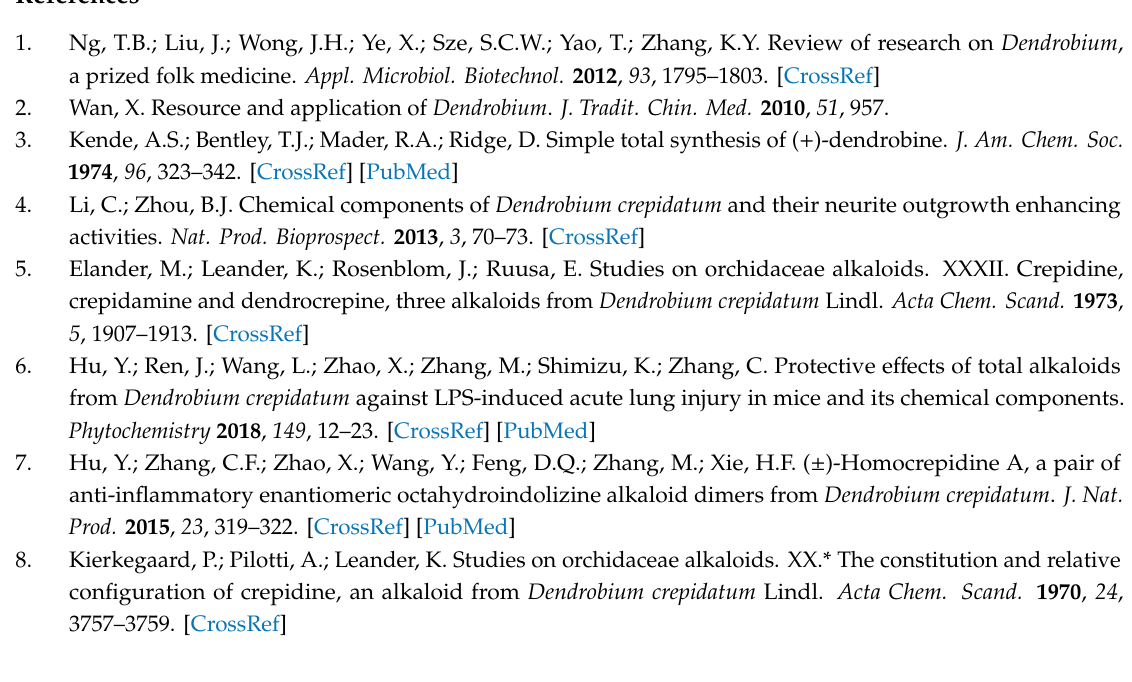
Supplementary Materials: The following including NMR, IR, UV and HR-ESI-MS spectra of compounds 1 and 2 are available